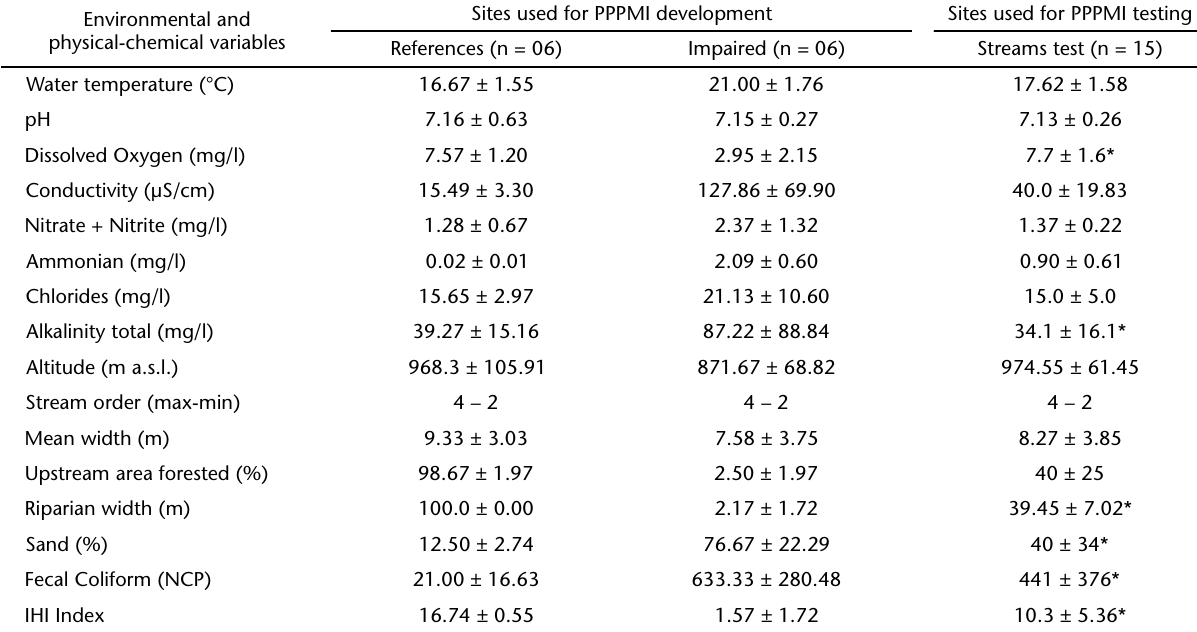
Table I. Environmental and physical-chemical variables measured at sites in the Serra dos Órgãos region,Rio de Janeiro, Brazil (Median, SD). * Indicates variables used during the analysis of the environmental PCA for the sensibility test of the Piabanha-Paquequer-Preto Multimetric Index (PPPMI). All sites (reference, impaired and test) have the same stream typology: size classes (based on catchment area- 10 -100 km 2 ), geology of the catchment area constituted of granite and altitude between 700-1200 m